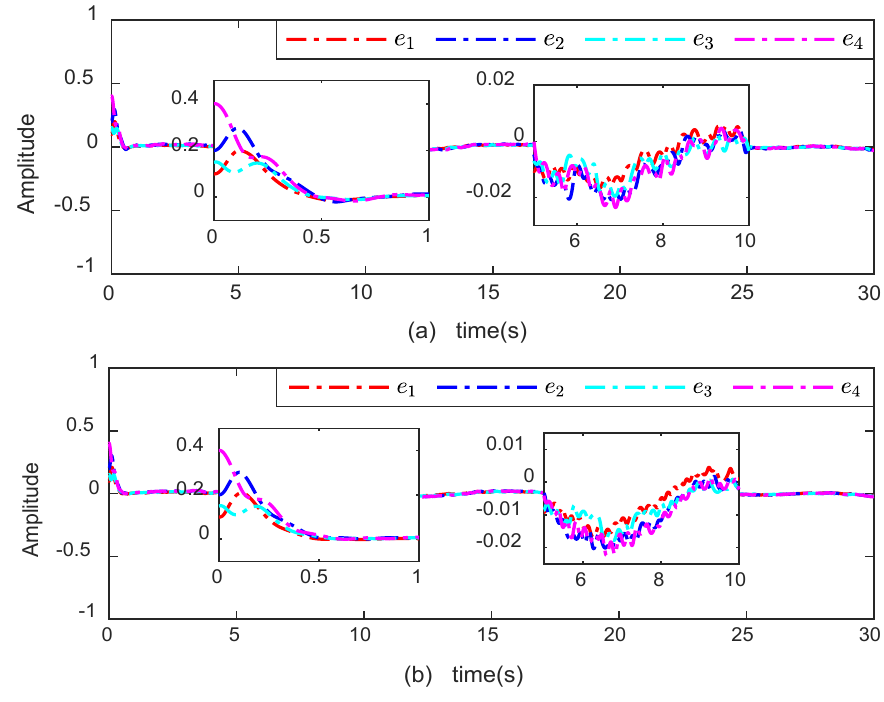
Figure 3. The trajectories of the containment tracking errors. ( a ) with quantized control. ( b ) without quantized control.